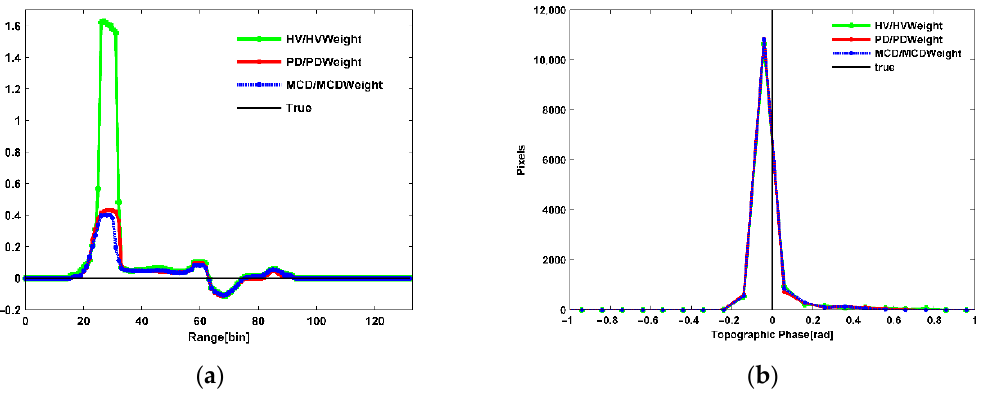
Figure 6. Image of estimated topographic phase. ( a ) HV/HVWeight method; ( b ) PD/PDWeight method; ( c ) MCD/MCDWeight method.